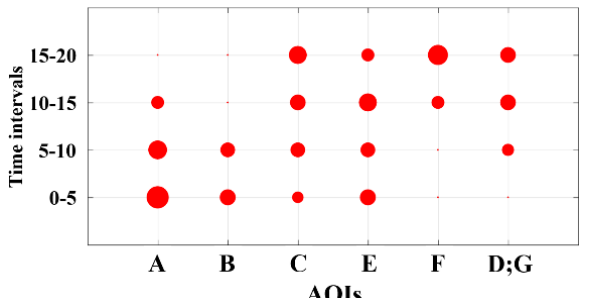
Figure 5. Sample dot plot showing the evolutions of the indegree measurements (for both single and overlap- ping AOIs) based on time frames using the results shown in Figure 4. Note that the time intervals need not be fixed but can be determined differently (e.g. dividing the time intervals based on events).